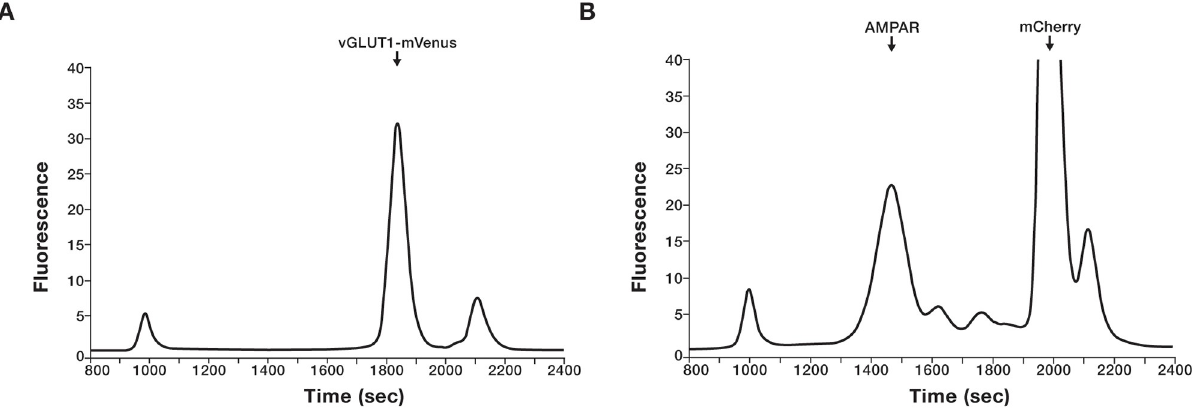
Fig 2. FSEC analysis of isolated glutamatergic synaptosomes. Detection of (A) vGLUT1-mVenus and (B) AMPAR bound to 15F1 Fab-mCherry in isolated synaptosomes using Venus ( λ ex: 510 nm, λ em: 530 nm) and mCherry ( λ ex: 580 nm, λ em: 610 nm) channels, respectively, via FSEC.